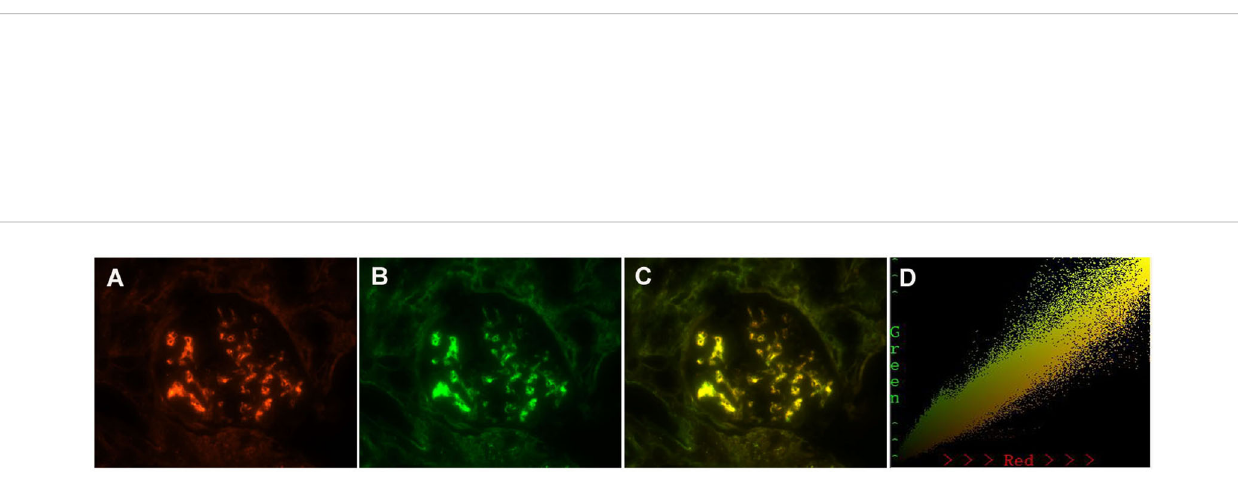
FIGURE 5 Paraf fi n-embedded sections for colocalization of galactose-de fi cient immunoglobulin A1 (Gd-IgA1) and C3c by immuno fl uorescence in patients with immunoglobulin A nephropathy (IgAN). Granular-positive staining of Gd-IgA1 (A) by immuno fl uorescence along the glomerular mesangial area in patients with IgAN. Granular-positive staining of C3c (B) by immuno fl uorescence along the glomerular mesangial area in the same section with Gd-IgA1. (C) Gd-IgA1 and C3c colocalized completely along the glomerular mesangial and capillary area. (D) The corresponding two-dimensional (2D) fl uorograms have been included to con fi rm the degree of co-localization (Pearson ’ s correlation = 0.976378, overlap coef fi cient = 0.985598). (A – C) : original magni fi cation